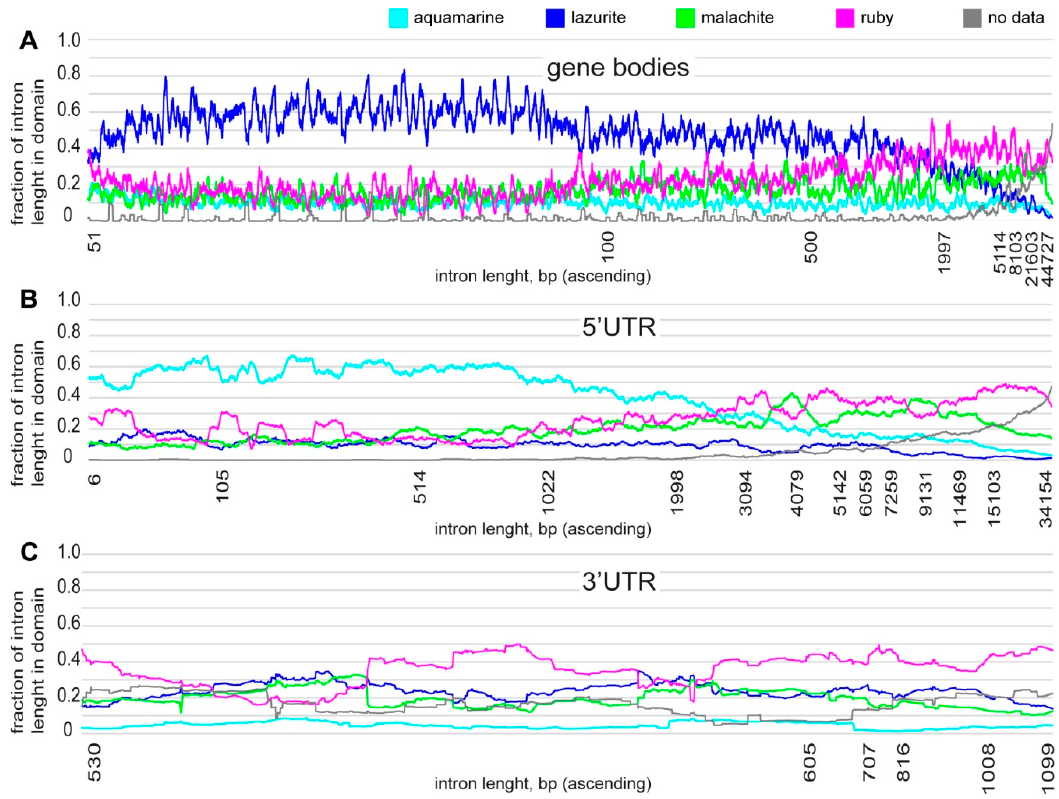
Figure 3. Intron fraction overlapping with four-chromatin states model [39] according to intron length (the calculations were carried out using moving average on the number of introns equaling 500; black line presents genome regions for which data on chromatin states is absent). (A) distribution for gene bodies; (B) distribution for 5’UTR; and, (C) distribution for 3’UTR.